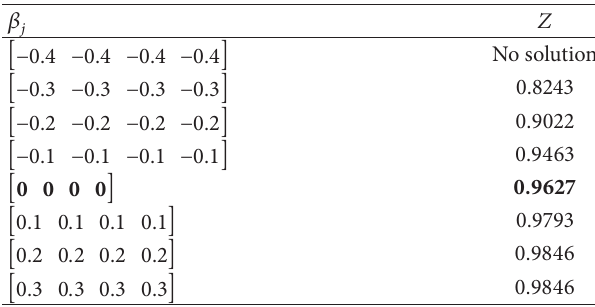
Table 4: The influence of 𝛽 𝑗 on comprehensive performance of LSSC 𝑍 .